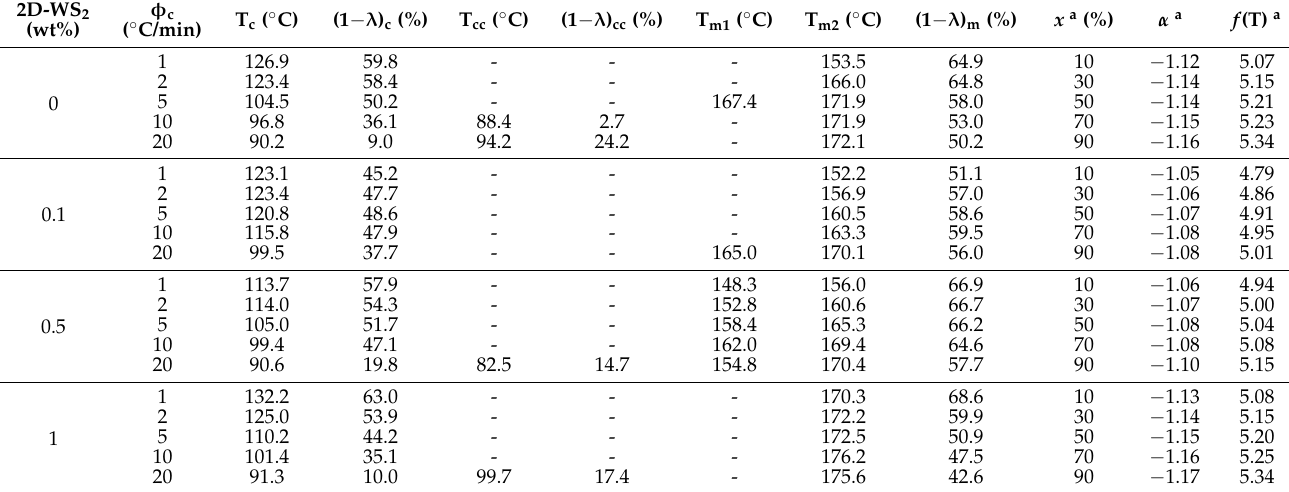
Table 2. Melt-crystallization and melting parameters of the neat PLLA and PLLA/2D-WS 2 nanocomposites. 2D-WS 2 (wt%)